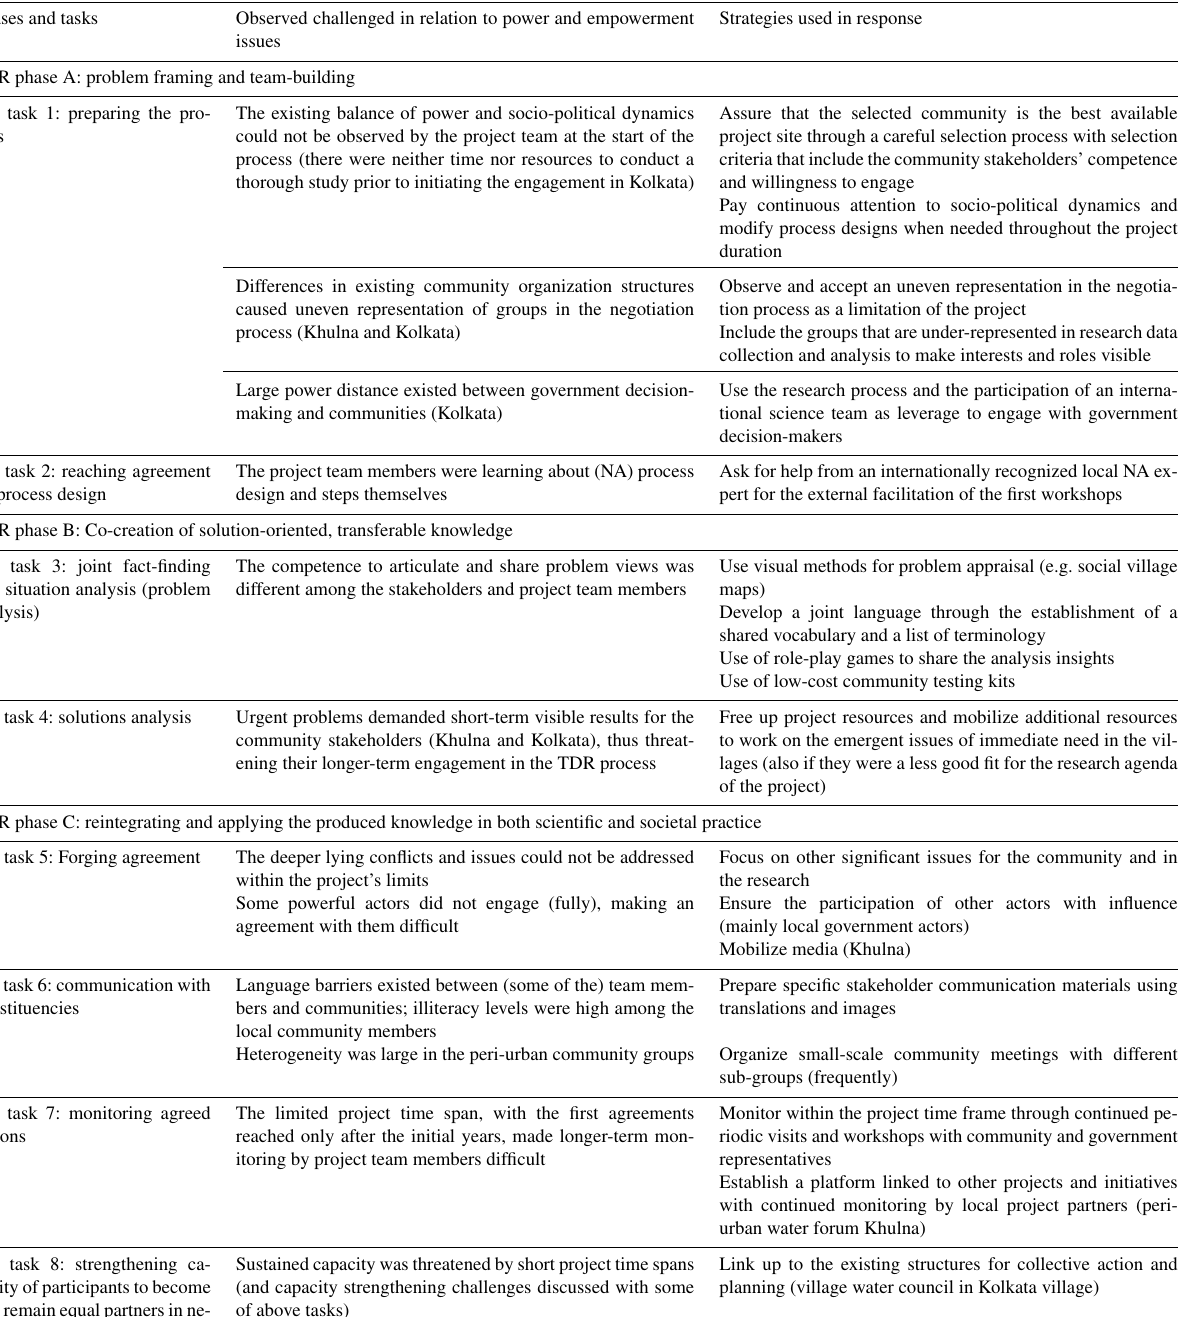
Table 3. Challenges and responses for the negotiated approach (NA) tasks in transdisciplinary water research (TDR) in peri-urban cases. Phases and